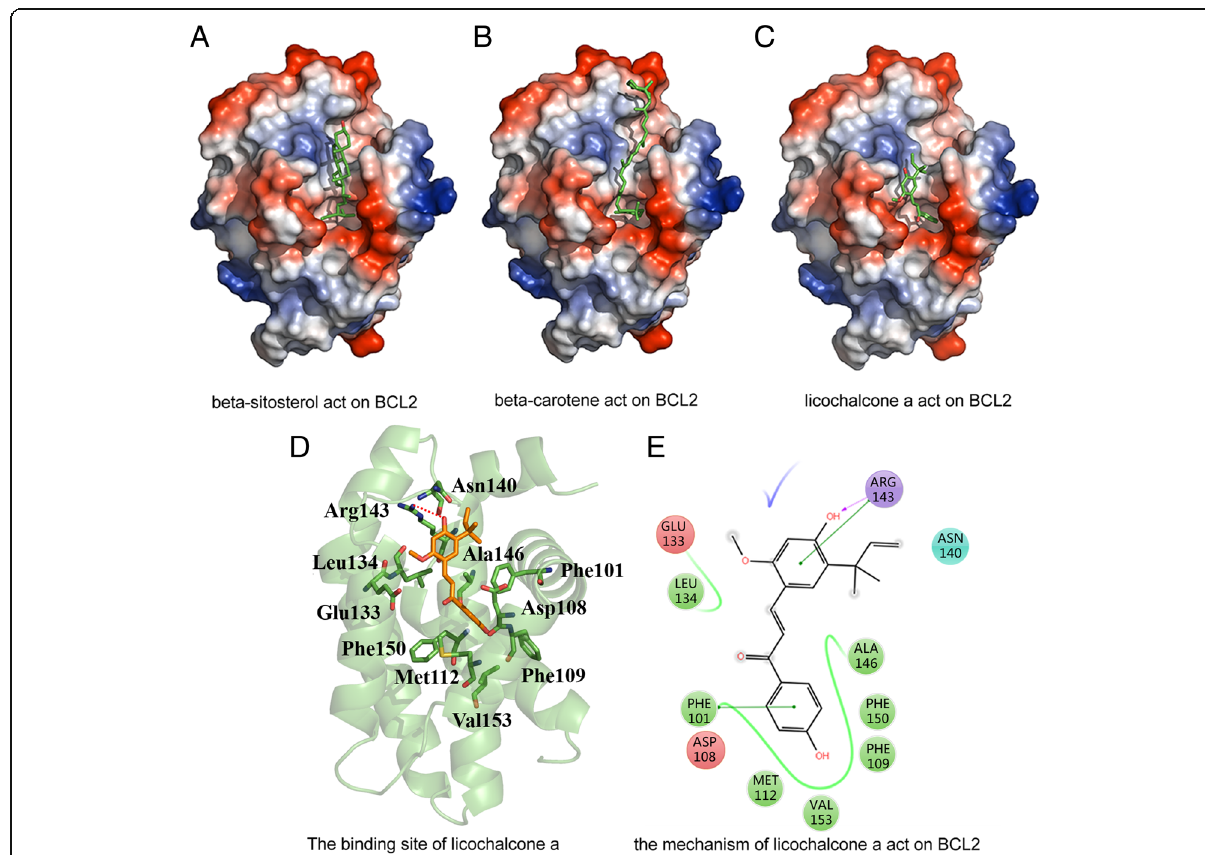
Fig. 8 The interactive modes of beta-sitosterol, beta-carotene, licochalcone a with BCL2. a beta-sitosterol binding on the pocket of BCL2. b beta- carotene binding on the pocket of BCL2. c licochalcone a binding on the pocket of BCL2. d the three-dimensional representation of the binding mode of licochalcone a with BCL2. The residues in the binding site are shown in green sticks and licochalcone a is shown in orange sticks. e the electrical characteristics of the surrounding residues of licochalcone a and the interaction between licochalcone a and BCL2. The green, cyan, red, blue circles represent hydrophobic, polar, negative-charged, positive-charged residues